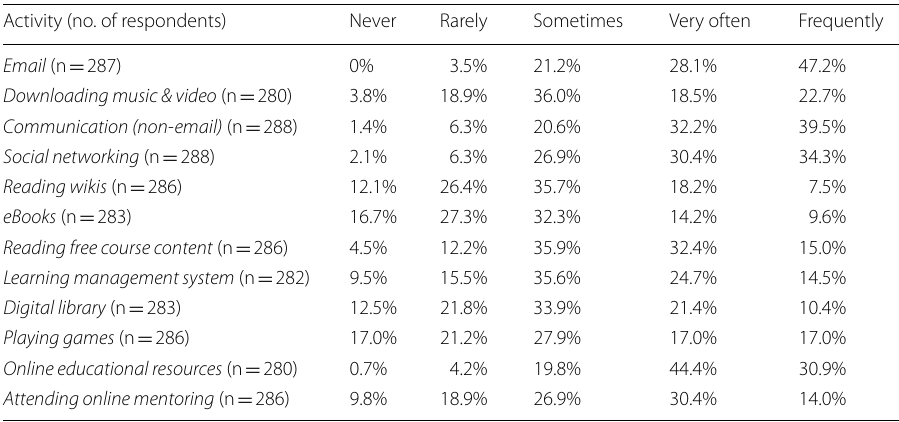
Table 2 Break-down of the student cohort by how frequently they participate in the listed ICT activities Activity (no. of